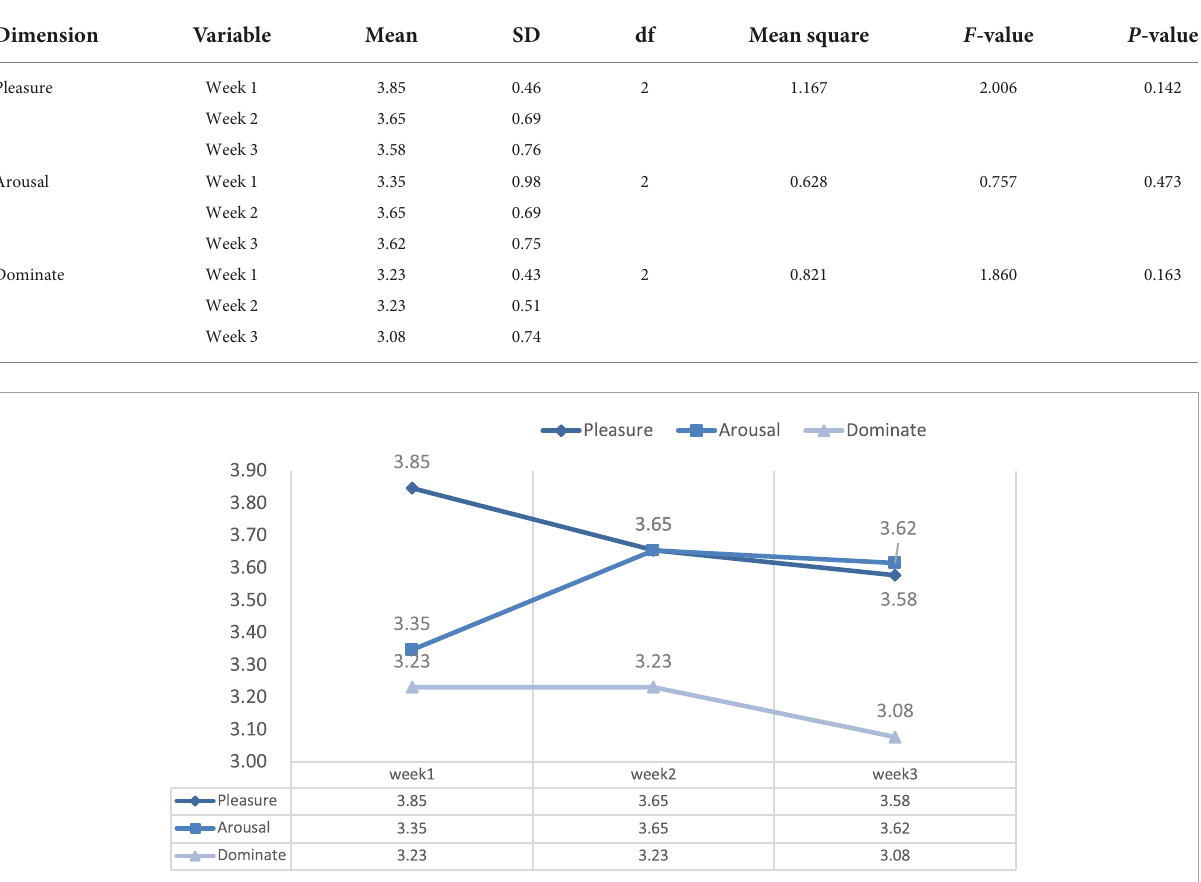
who were willing to be interviewed responded positively to the VR experience. After the first week of the experiment, the 360-degree nature video provided content with a sense of